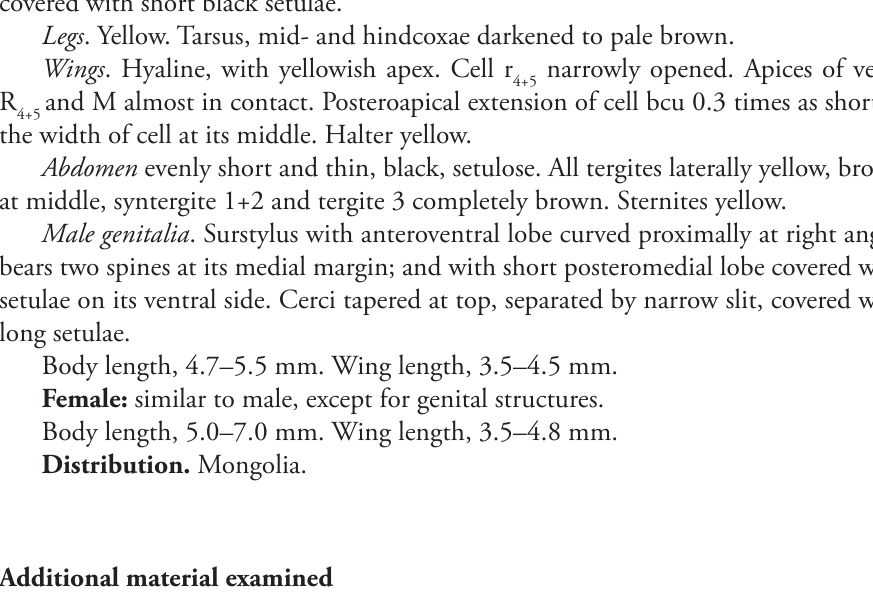
Type material. Lectotype male: China: “syntypus, Бугасъ у Хами, на ЮВ от Тянь- Шаня, РобКозлов , 25.VIII.1895” [Bugaz near Hami, to the SE from Tien Shan, 25.VIII.1895, Roborowsky and Kozlov leg.] (ZISP). Paralectotypes: China: 3 males, 1 female, 25.VIII.1895, label as in lectotype; 1 male 28.VIII.1895, 1 female 20.VIII.1895, labels as in lectotype (ZISP); 4 males, 1 female, label as in lectotype